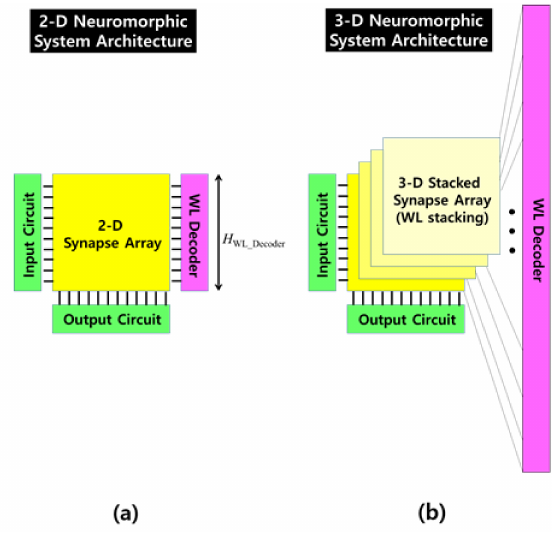
Figure 2. Metal interconnection scheme of synapse array architecture. ( a ) 2-D neuromorphic system architecture; ( b ) 3-D neuromorphic system architecture (a bad design example).